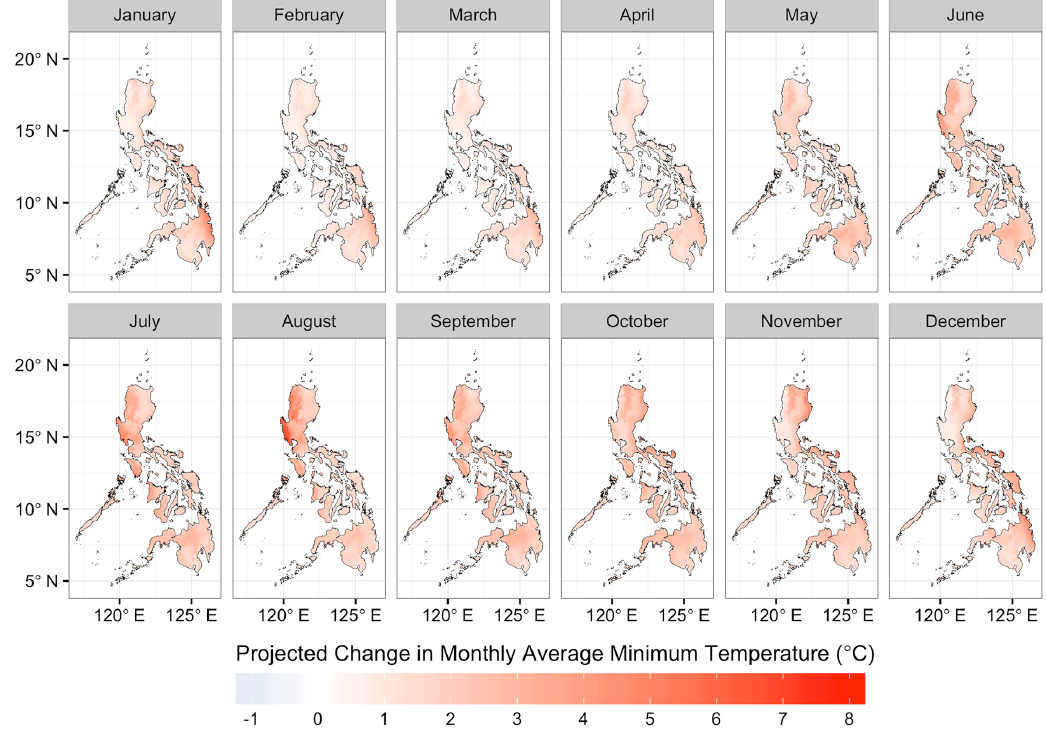
Fig. 7. Spatial distribution of projected changes in monthly average minimum temperature in the Philippines under future climate condition